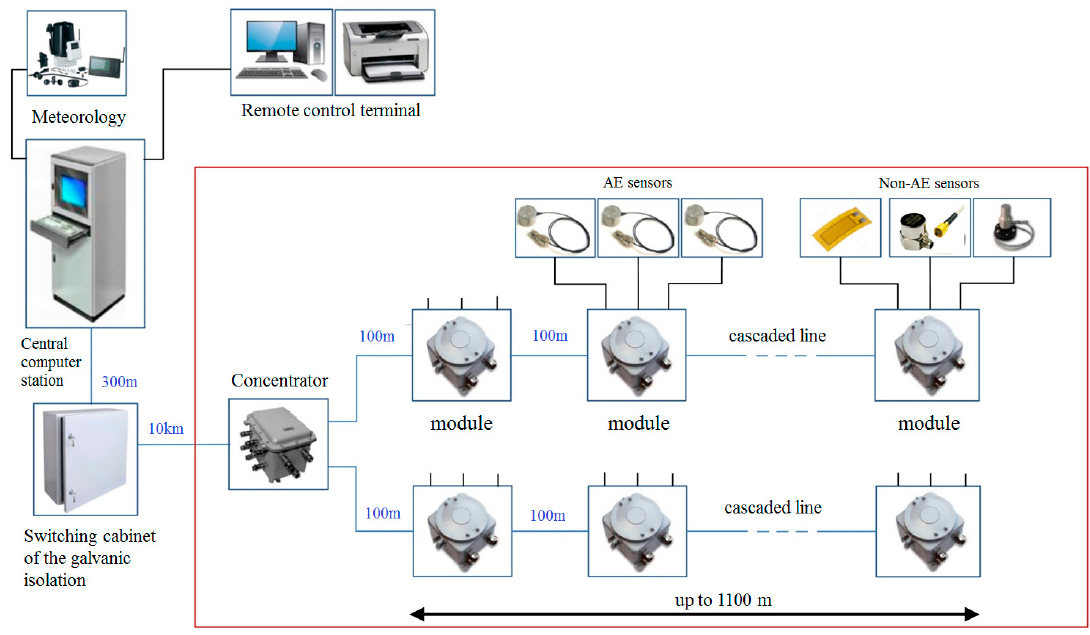
Figure 1. Example of structural health monitoring (SHM)-system structural scheme.